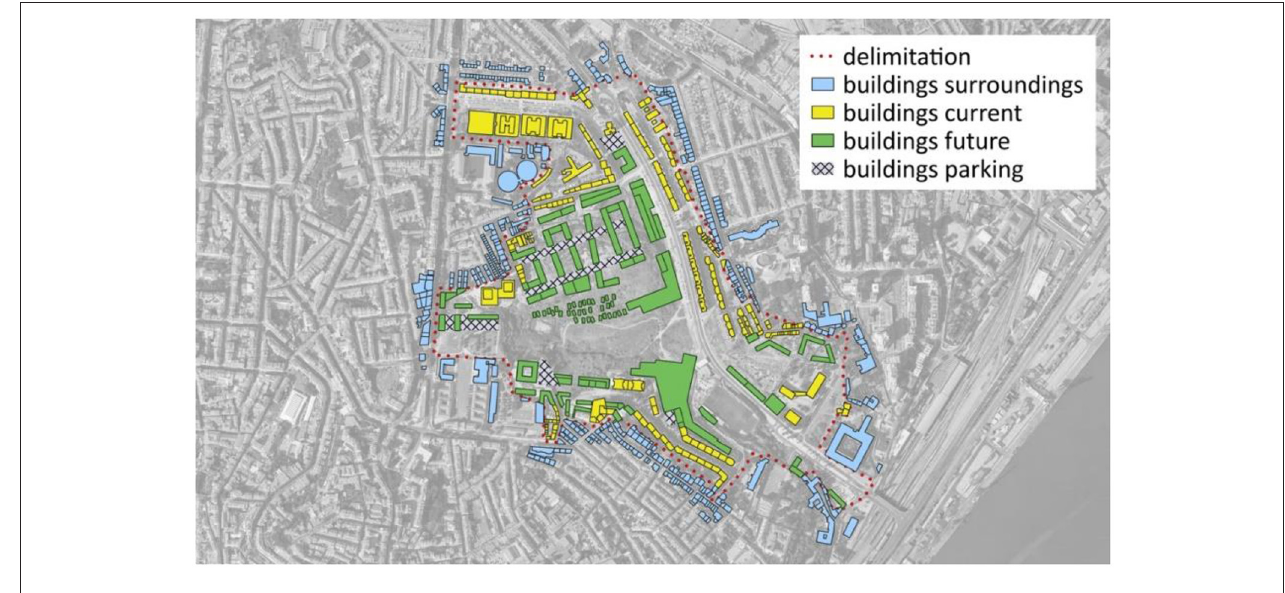
FIGURE 1 | VSA buildings layer.